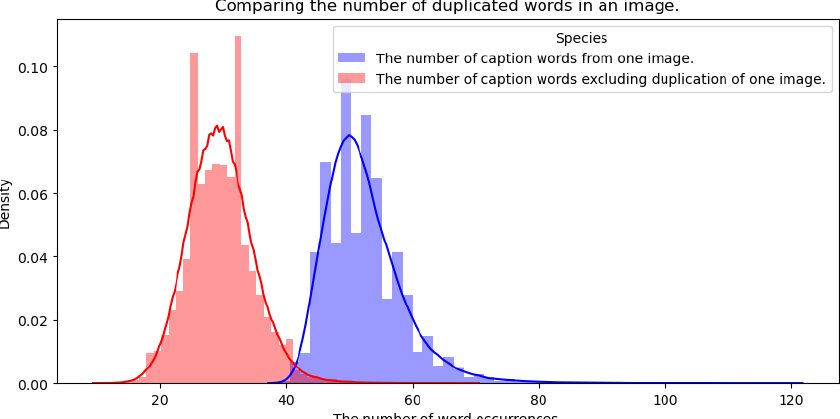
Figure 4. Comparing the de-duplication and removed word occurrence distribution of five explana- tory sentences for one